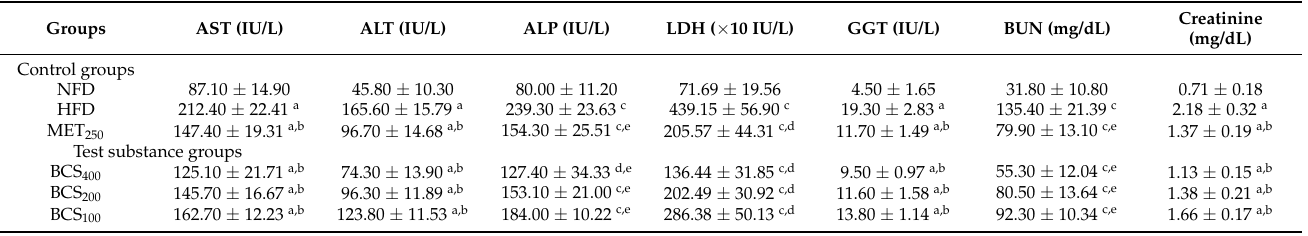
Table 6. Serum AST, ALT, ALP, LDH, GGT, BUN, and creatine content in HFD- and NFD-supplied groups.